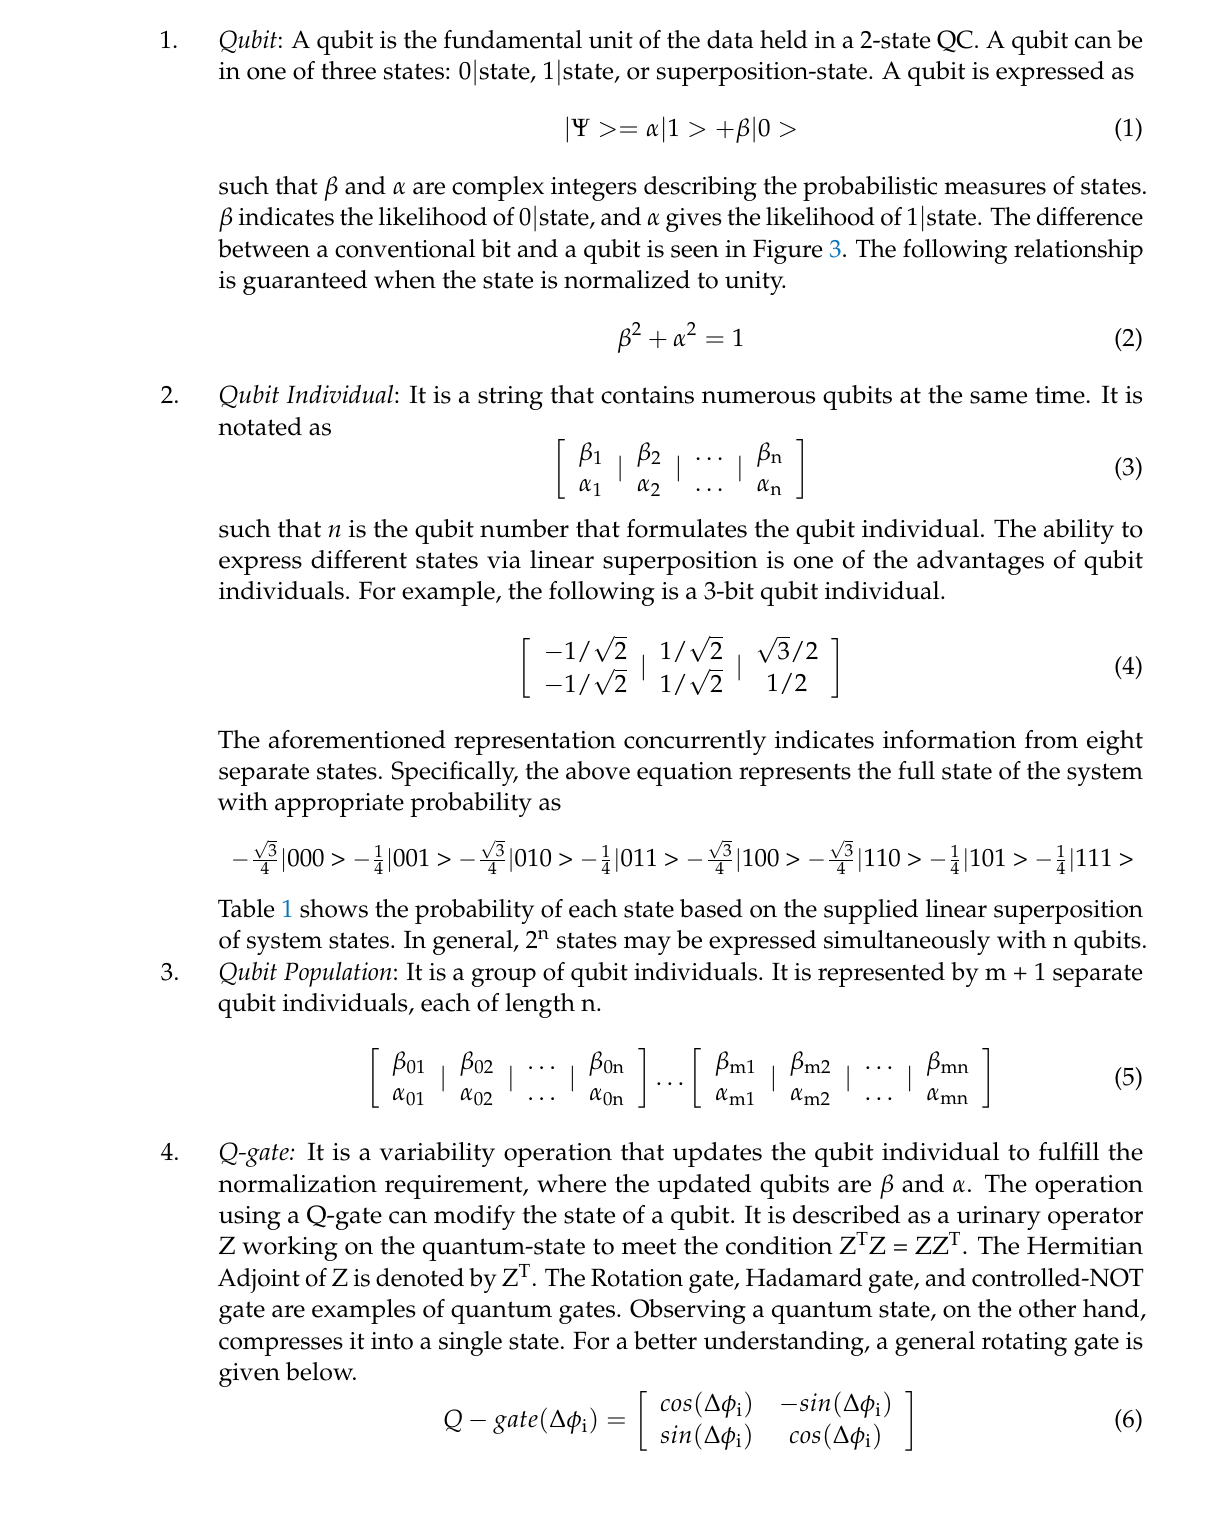
1. Qubit : A qubit is the fundamental unit of the data held in a 2-state QC. A qubit can be in one of three states: 0 | state, 1 | state, or superposition-state. A qubit is expressed as